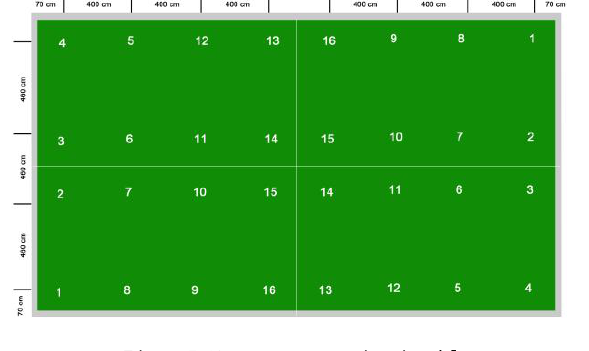
Figure 5. Measurement points in table